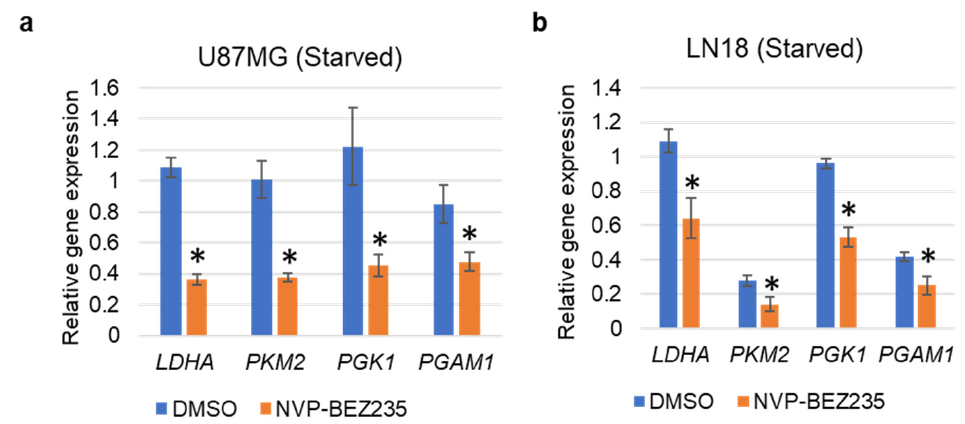
Figure 4. qRT-PCR validation of the glycolysis-related genes under serum starvation in ( a ) U87MG, and ( b ) LN18 cell lines grown in serum-free medium. The relative expression of the genes (compared to ACTB , encoding actin) was analyzed in control DMSO and NVP-BEZ235 samples (five days 1 µ M NVP-BEZ235 with no FBS). The error bars represent the standard deviation of the genes (n = 4). Asterisks (*) represent the significantly expressed genes ( p < 0.05) as compared to control (DMSO). Significance was determined by Student’s t -Test.